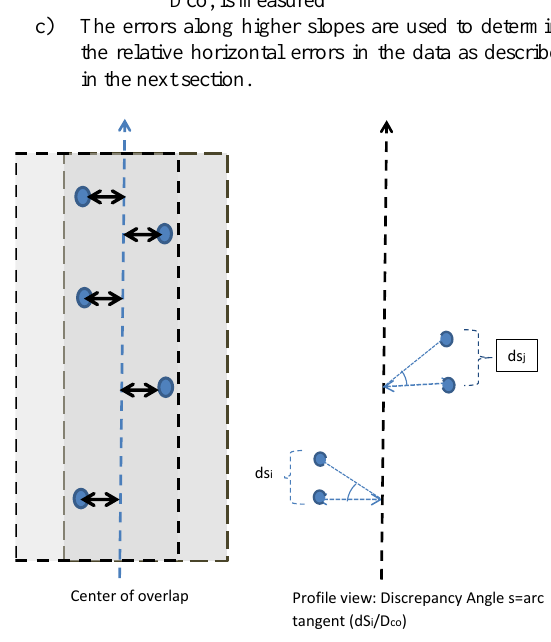
Figure 5 Analysis of DQM errors and center line of